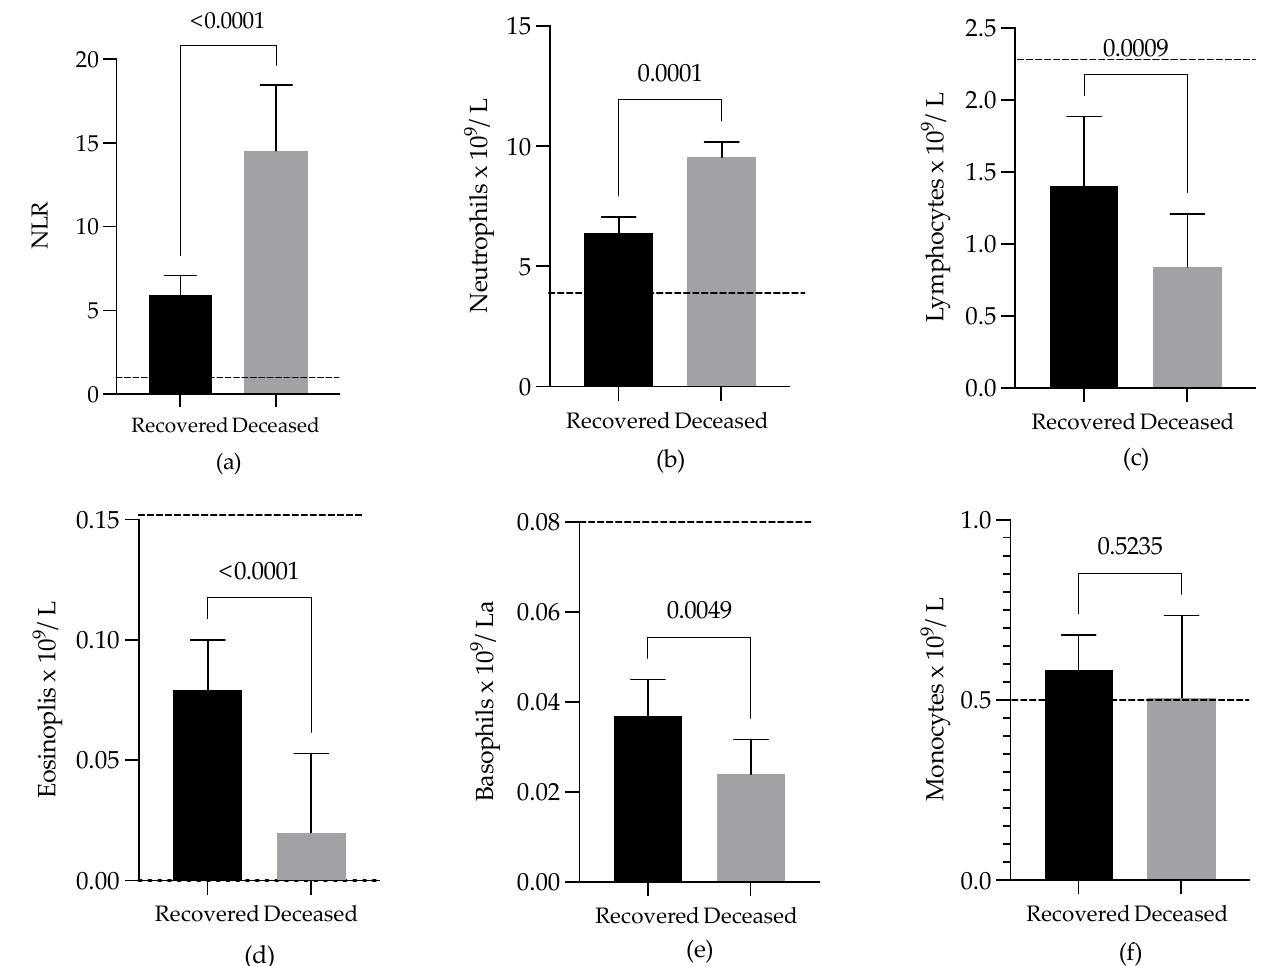
Figure 2. Comparison of ( a ) neutrophil-to-lymphocyte ratios (NLRs) and ( b – f ) white blood cell WBC differential counts of COVID-19 patients with different outcomes. The median values of 152 WBC differential counts with their respective NLRs from 59 recovered patients were compared with the median values of 126 WBC differential counts and NLRs from 60 deceased patients. Bars indicate standard errors. The dashed lines indicate the means of normal values of NLRs or leukocytes. The analysis was performed using the Wilcoxon matched-pairs test.